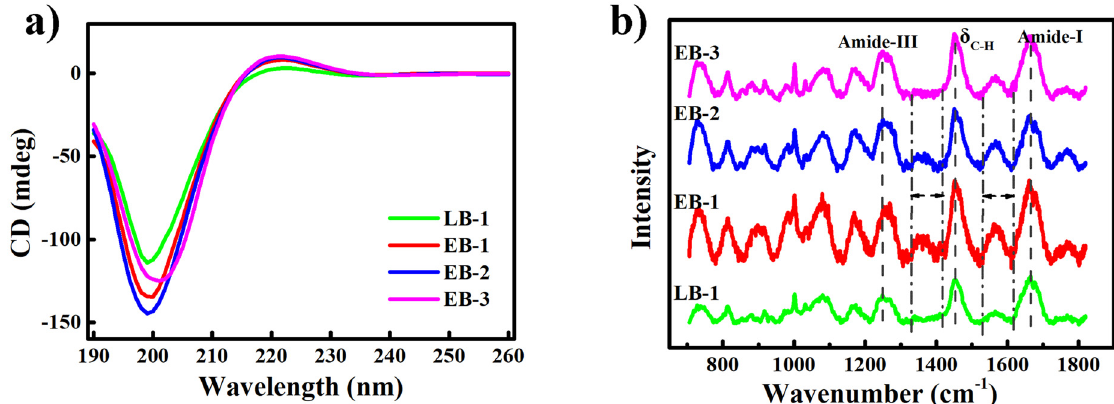
Figure 4: ( a ) Circular dichroism spectra; ( b ) Raman spectra of the gelatin